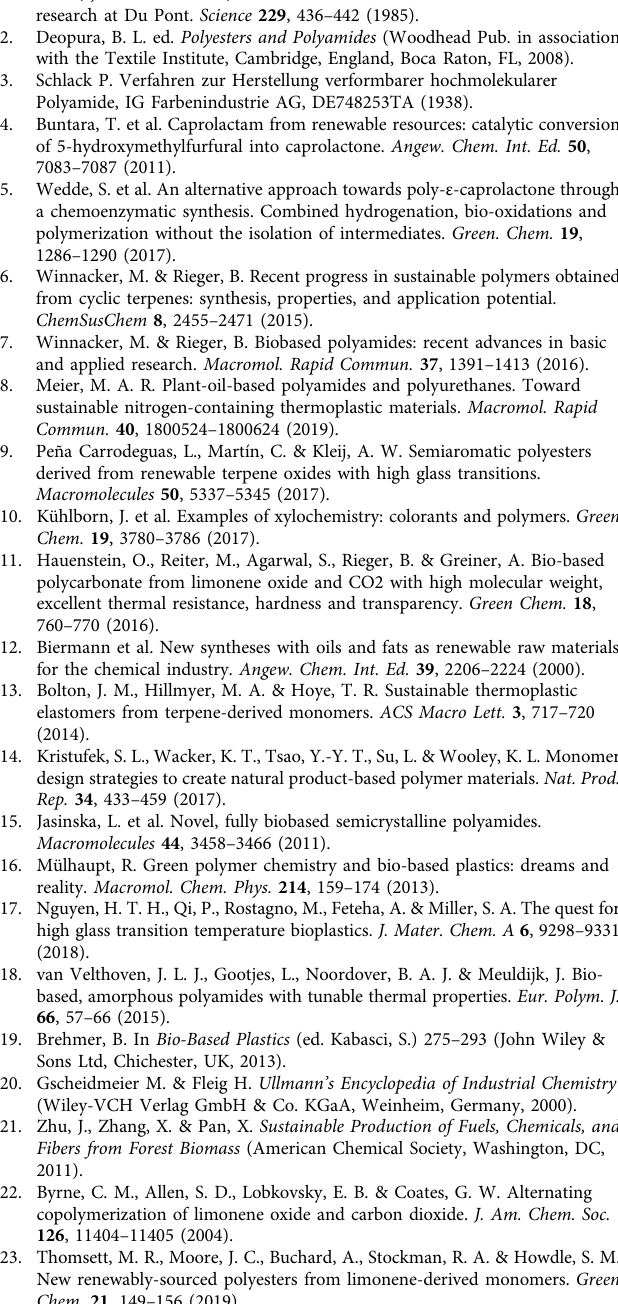
Table 8. The ratio of lactam 5-3S and the speci fi c co-monomer (Built-in) of the polyamides copoly( 5-3S·5-3R ), copoly( 5-3S·LL ), and copoly( 5-3S·5-CL ) was investigated by NMR. The protons used for integration and comparison are highlighted in Supplementary Fig. 27; the results are displayed in